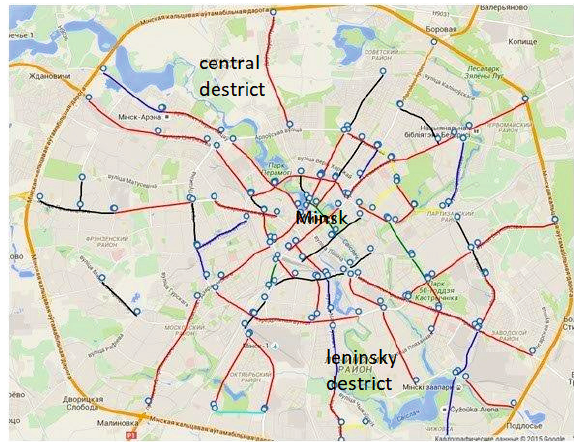
Figure 5. Colour differentiation of routes by